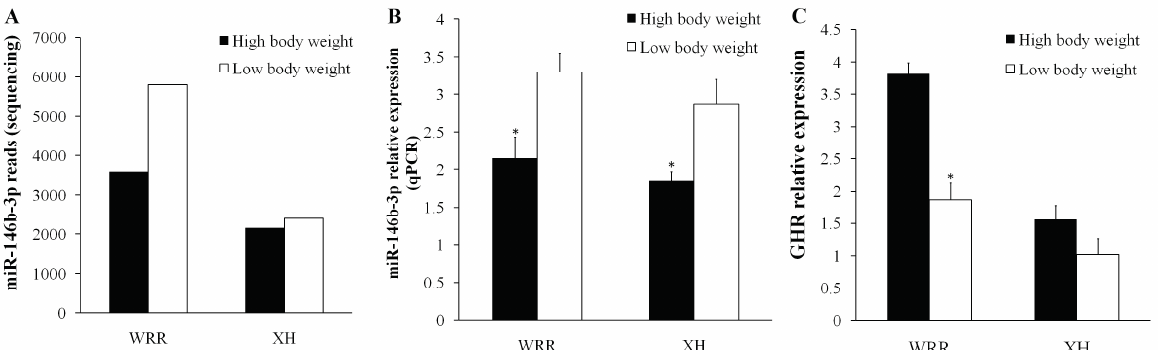
Figure 7. The expression of miR-146b-3p and GHR in breast muscle of two-tail samples of WRR and XH. ( A ) The reads of miR-146b-3p in four sequencing samples; ( B ) The expression of miR-146b-3p in two-tail samples of WRR and XH detected by qPCR; ( C ) The expression of GHR in two-tail samples of WRR and XH detected by qPCR. All of the results are expressed as the mean ± S.E.M. of three replicates. * p <